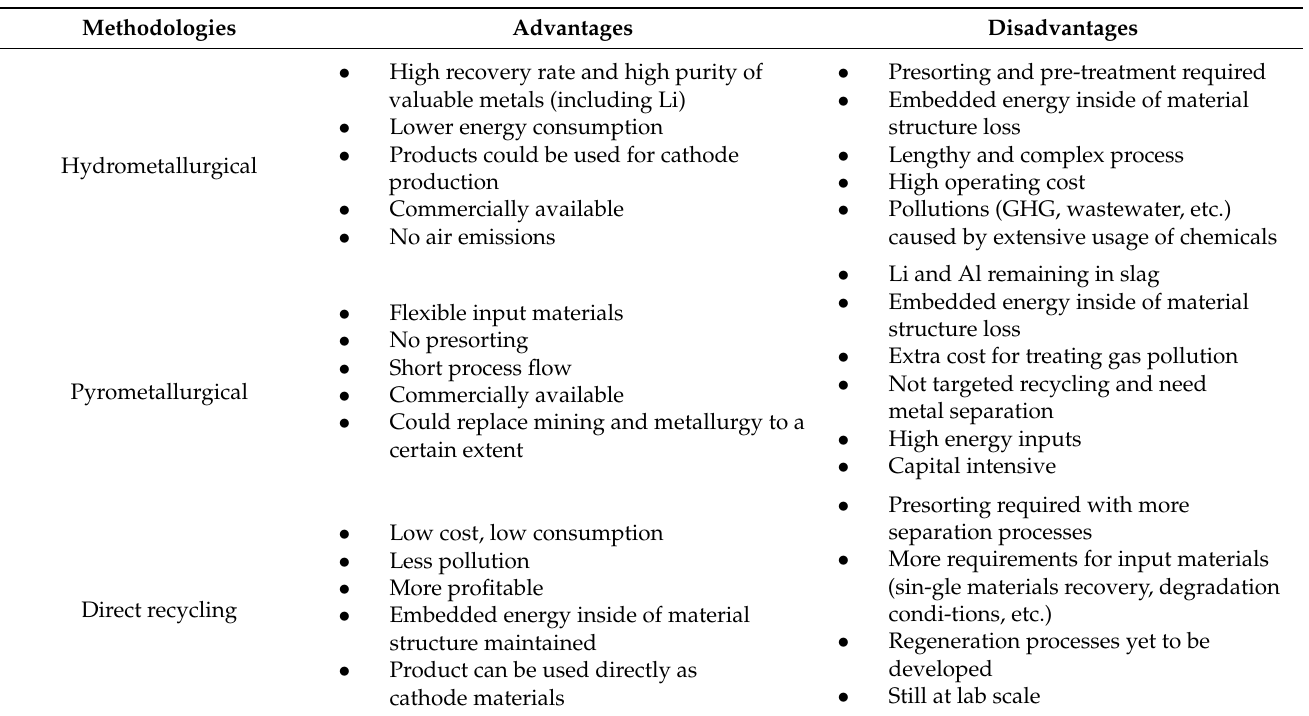
Table 3. Challenges and opportunities of hydrometallurgical, pyrometallurgical, and direct recycling processes